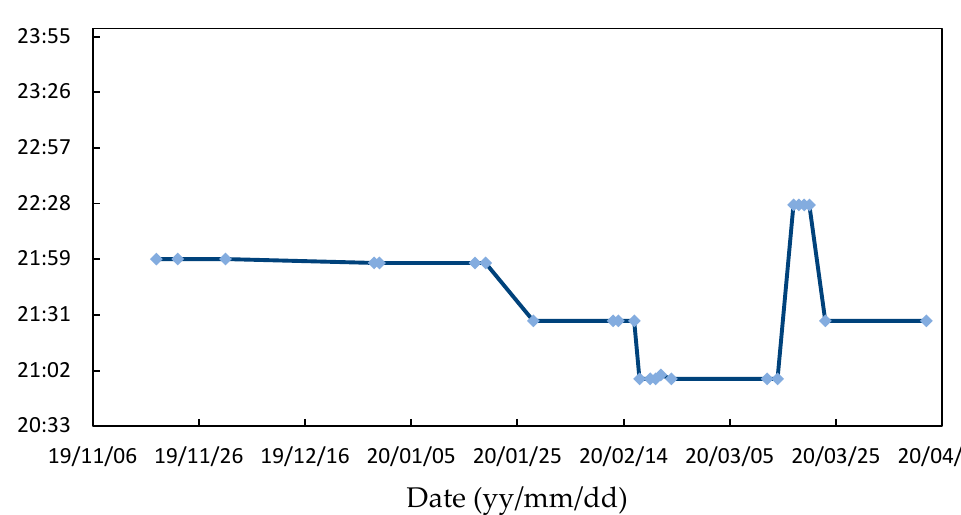
Figure 5. The earliest detected STLs from 1 November 2019 to 12 April 2020.